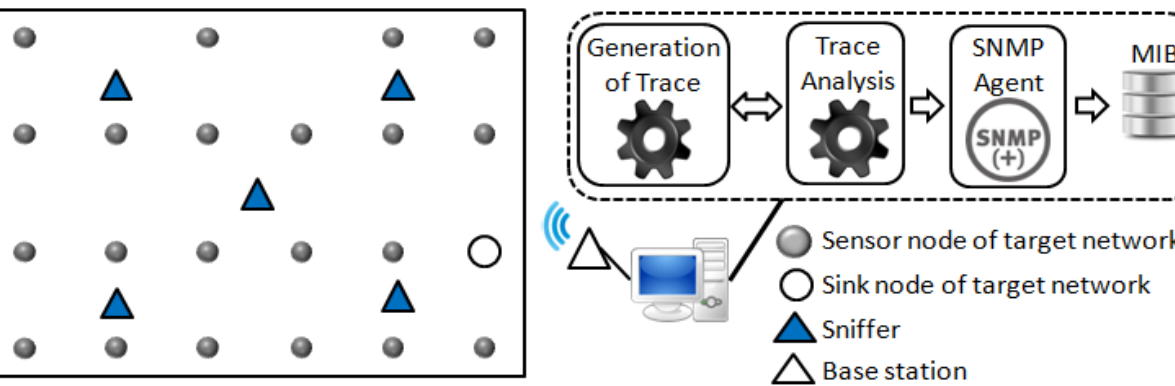
Figure 11. Scenario used in the experiments.